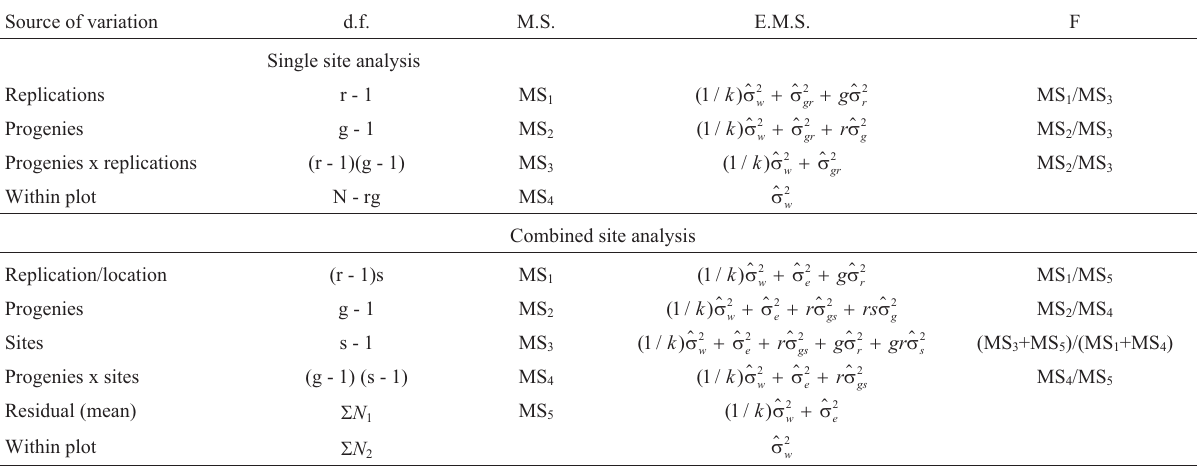
Table 2 - Analysis of variance (ANOVA) degrees of freedom (df) and expected mean square (E.M.S.) equations for the single site and combined site models for estimating the variance due to differences among plants within plots in a rubber tree progeny trial at three sites in the Brazilian state of São